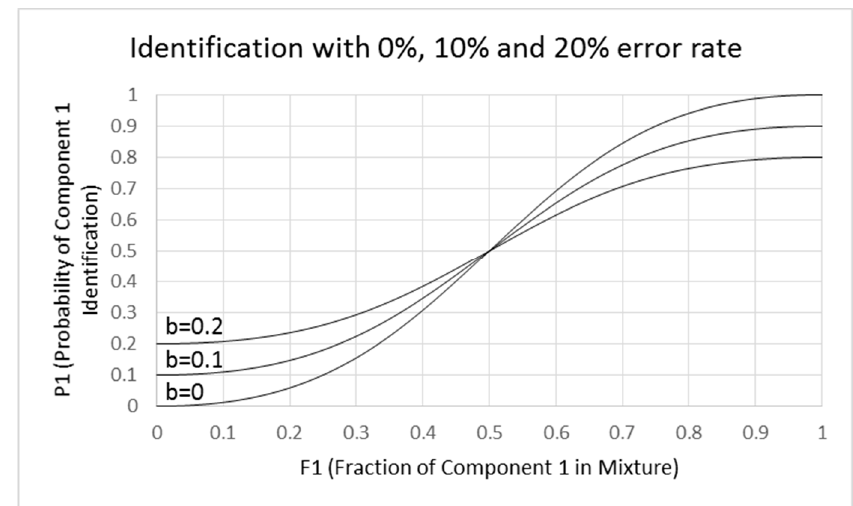
Figure 8. Binary mixture odor identification error: Hettinger and Frank model. Model of component identification showing effect of identification errors show three binary-odor identification error-rates for mixture components. Errors are reflected in the existence of an intercept b for the P1 function when F 1 = 0. Three plots are given: (1) b = 0 where no identification errors occur, (2) b = 0.1 where the error rate is 10% and (3) b = 0.2 where the error rate is 20%. The plots are for the equation P 1 = [(1 − b)F 12 + b(1 − F 1 ) 2 ]/[F 12 + (1 − F 1 ) 2 ] which shows increasing flattening of the function with increasing error rate. The slope at the inflection point is 2 × (1 − 2b). When b = 0, the curve is identical to that shown for P1 in Figure 7. The slope and intercept have different meanings from those of Ferreira [16].